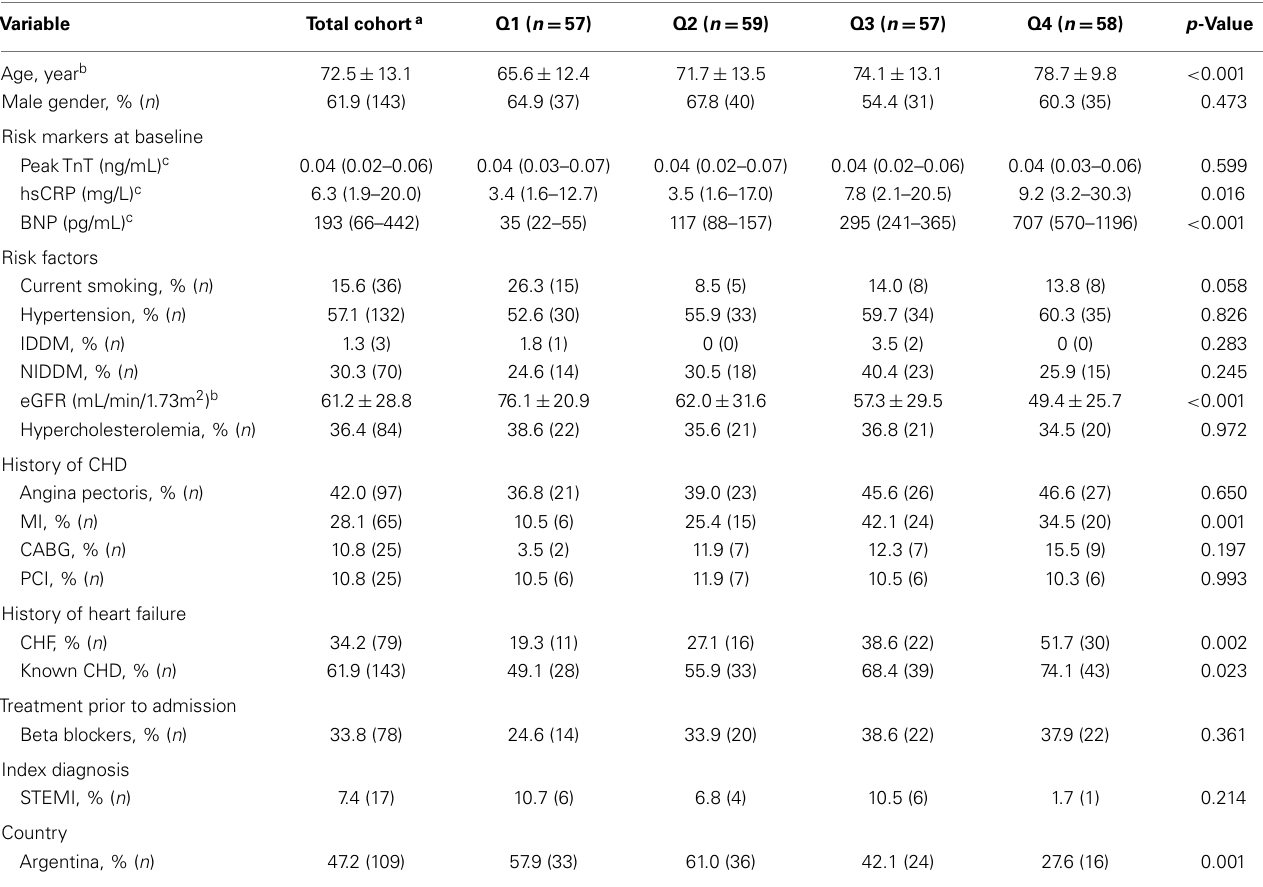
Table 1 | Baseline characteristics according to BNP (pg/mL) quartiles